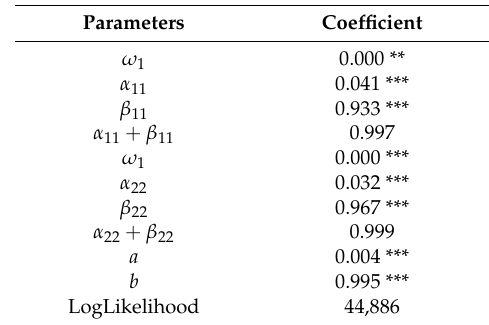
Table 2. DCC estimation results.